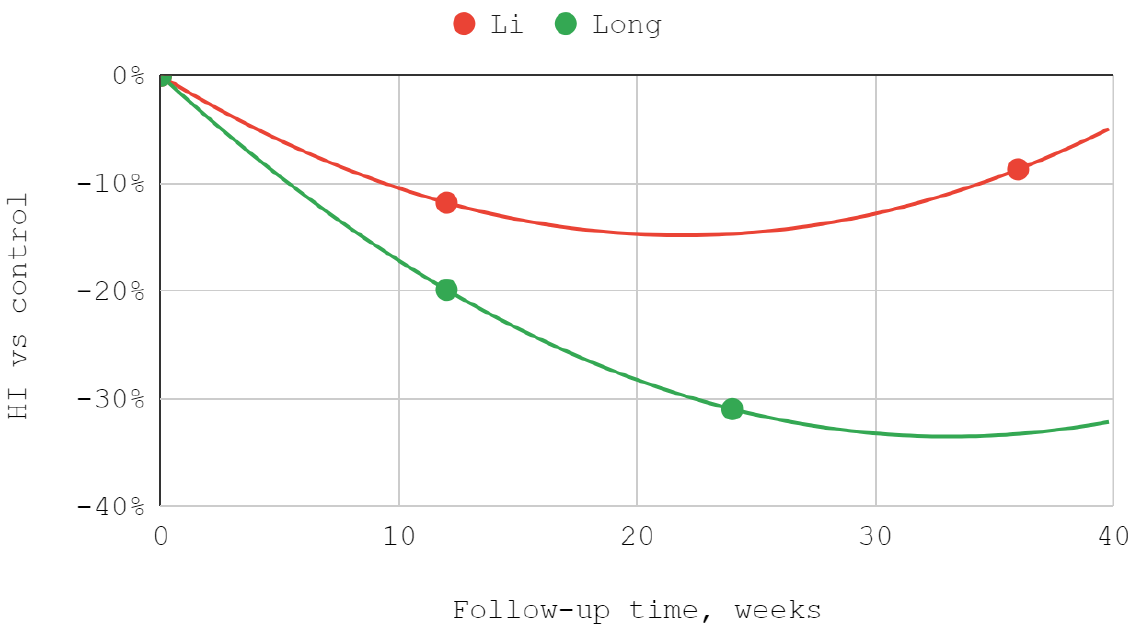
Figure 8. The efficiency of inferior versus superior compartment TMJ treatment in Helkimo index (HI) domain over time.